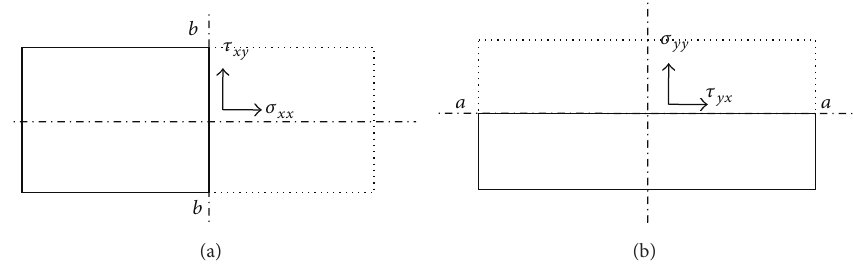
Figure 7: Transistor sections analyzed in the ESPI measurements.